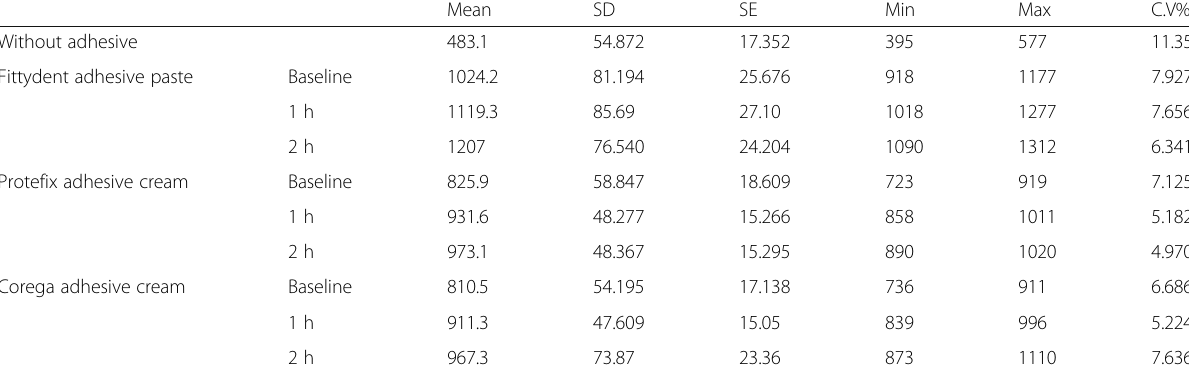
Table 1 Mean dislodgement forces in grams with standard deviation of poorly fitting mandibular complete dentures without adhesive and at various time intervals with the use of denture adhesives Mean SD SE